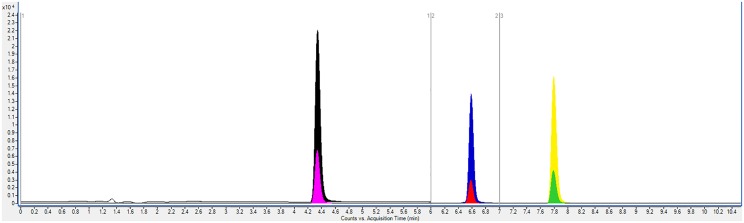
Overlaid UPLC-MS/MS SRM chromatograms of 1000 ppb mixed polyamines standard (0–10 mins being shown).Put (Black peak, tR = 4.3 min), Put-d8 (Pink peak, tR = 4.3 min), Spd (Blue peak, tR = 6.6 min), Spd-d8 (Red peak, tR = 6.6 min), Spm (Yellow peak, tR = 7.9 min) and Spm-d8 (Green peak, tR = 7.9 min).